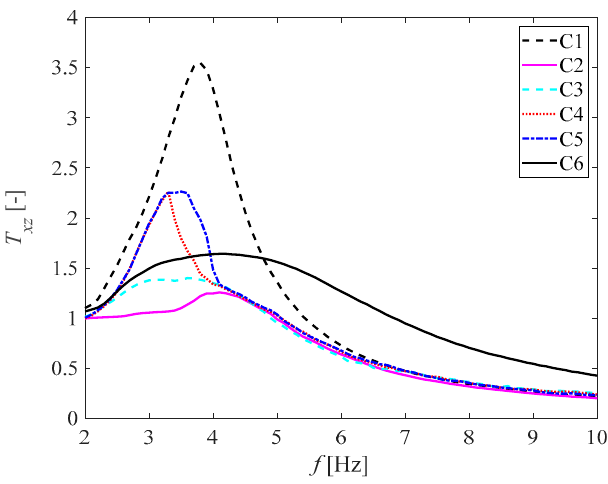
Figure 12. Transmissibility coefficient T xz vs. frequency f.